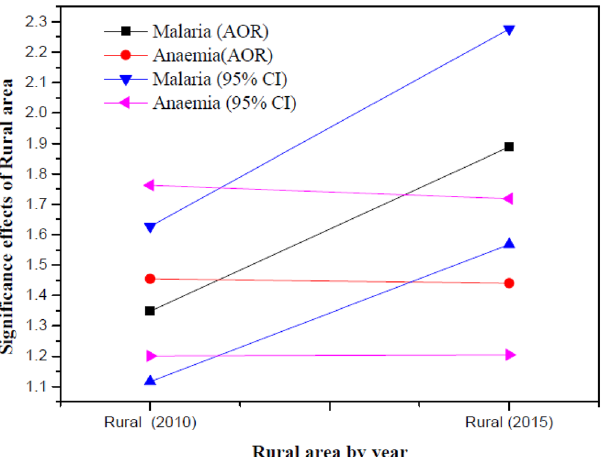
Figure 7. Estimated significance of non-linear effect of rural area, the posterior mean and the 95% credible